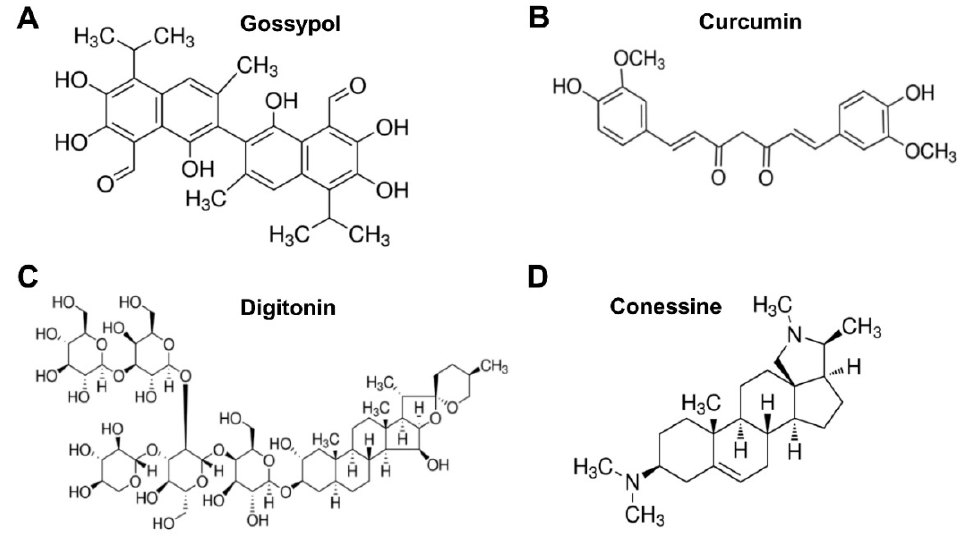
Figure 2. Structure of four lead natural products. Gossypol ( A ), curcumin ( B ), digitonin ( C ), and conessine ( D ) were initially identified as anti-ZIKV (strain PAN2016) inhibitors.